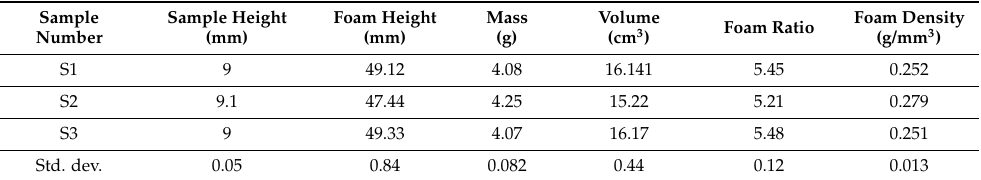
Table 4. Results of the confirmation experiment using the parameters recommended by the Taguchi analysis.